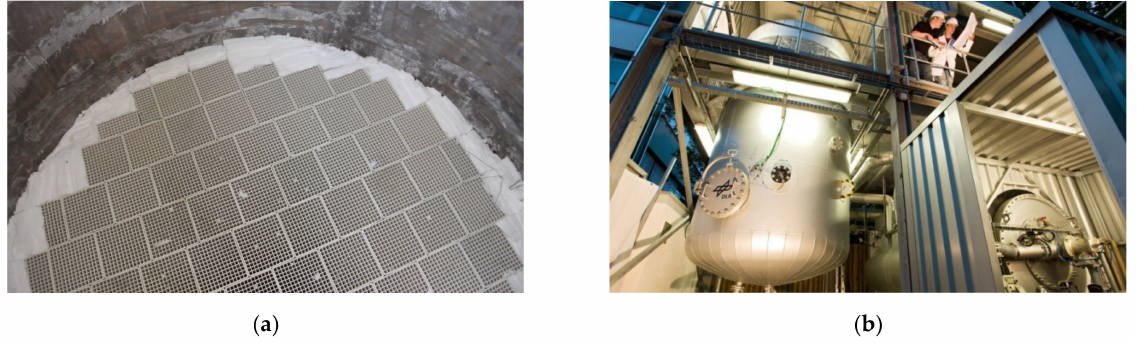
Figure 19. Experimental setup: ( a ) honeycomb inventory and insulation; ( b ) HOTREG test facility.